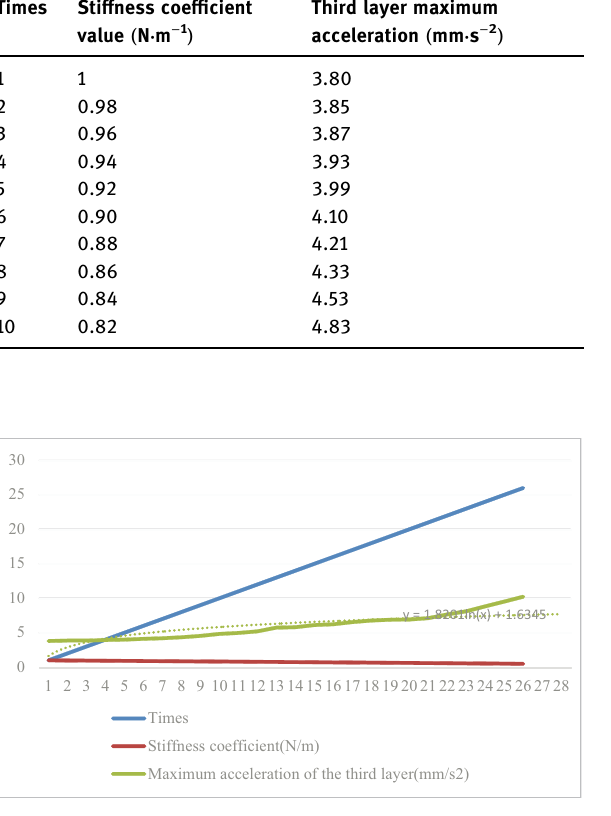
Table 2: The fi rst ten simulations of data statistics Times